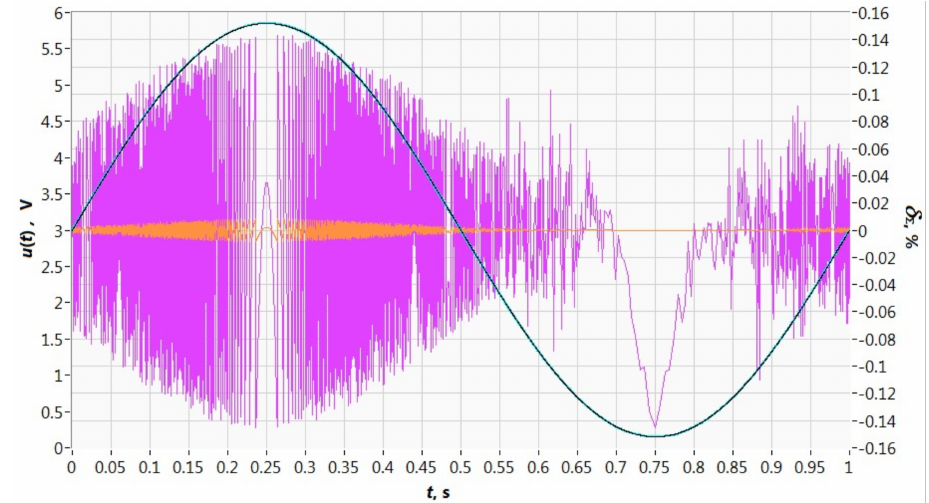
Figure 16. The results of the simulation of processing for the thresholds N xi min = 1000, N xi max = 1744. In summary, it can be stated that increasing f 0 for small values of T xi periods reduces the quantization error δ k . Increasing T 0 for large values of T xi periods causes an increase in the averaging error δ a , which forces an increase in the intermediate values of the processing error δ ∑ and a decrease in the numerical values of N xi representing the consecutive periods T xi . However, the threshold value of N xi max may be chosen such that the maximum processing error for the lower range will not